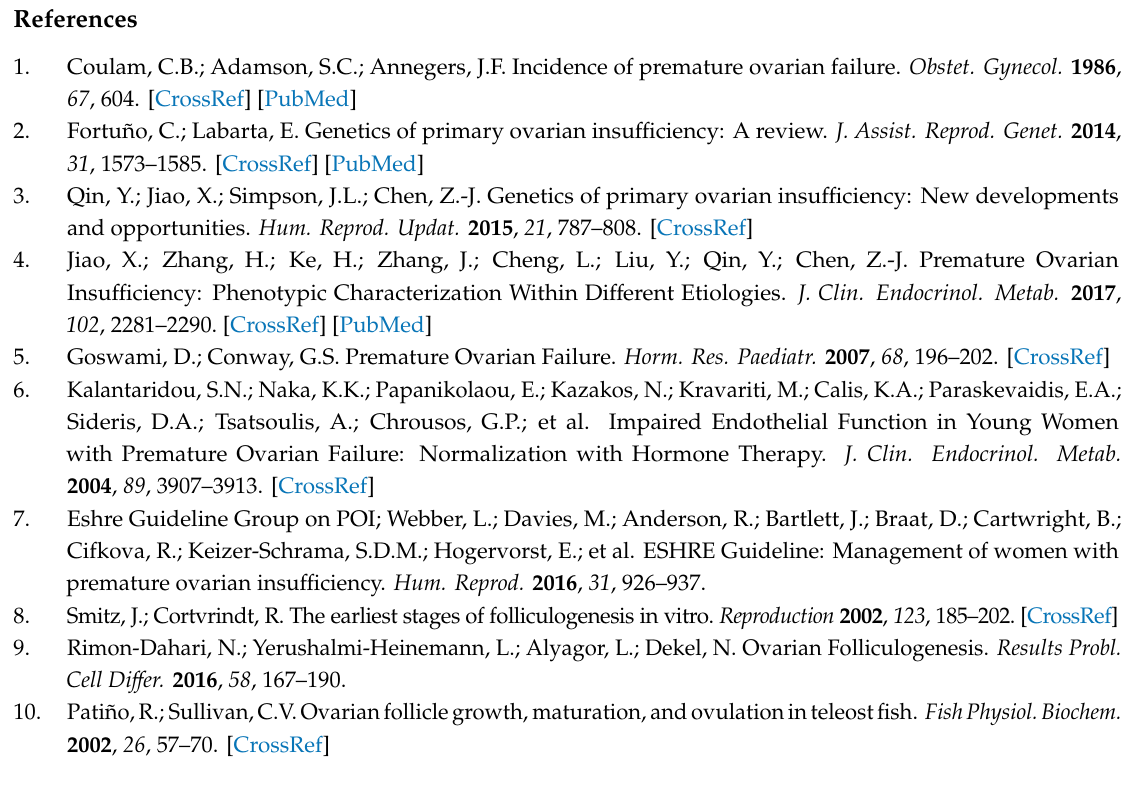
Figure S1. Quantile-quantile plot for GWAS data from 60 patients with premature ovarian failure and 182 controls. Figure S2. Flow chart of data processing in the discovery and replication sets. Table S1. Genotypes of rs55941146 in samples included in this study. Table S2. Comparison of allele frequency in recruited samples and variable population of 1000 genomes. EAS, east Asian; CDX, Chinese Dai in Xishuangbanna, China; CHB, Han Chinese in Beijing, China; CHS, Southern Han Chinese; JPT, Japanese in Tokyo, Japan; KHV, Kinh in Ho Chi Minh City,